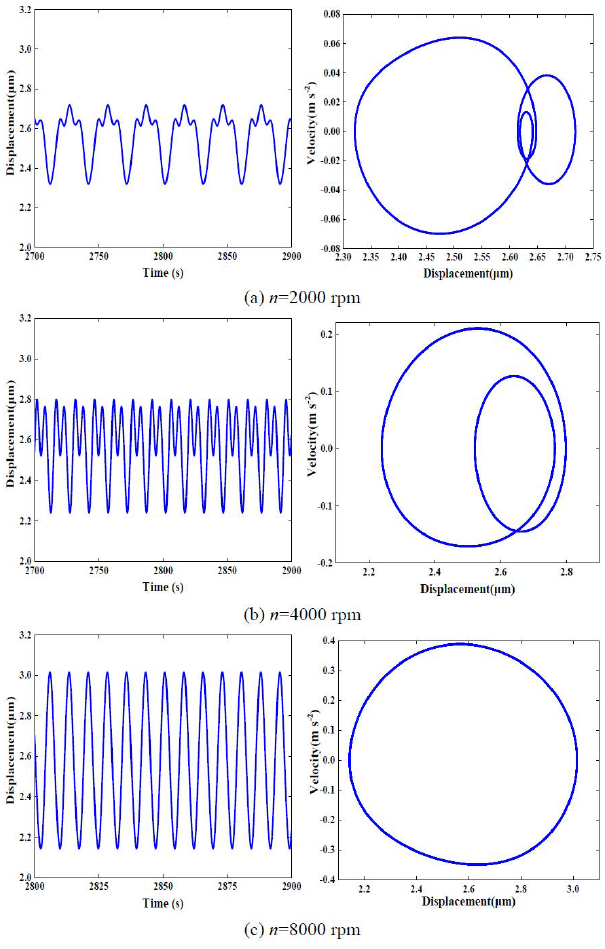
Figure 4. Vibration response of the internal meshing pair at differ- ent speeds.